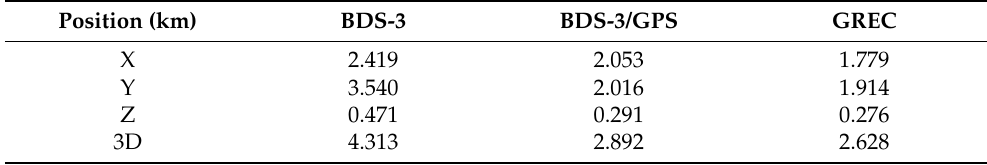
Figure 18. Differences between GREC SPP and the nominal lunar trajectory. Table 11. RMS of Position with different system combinations.